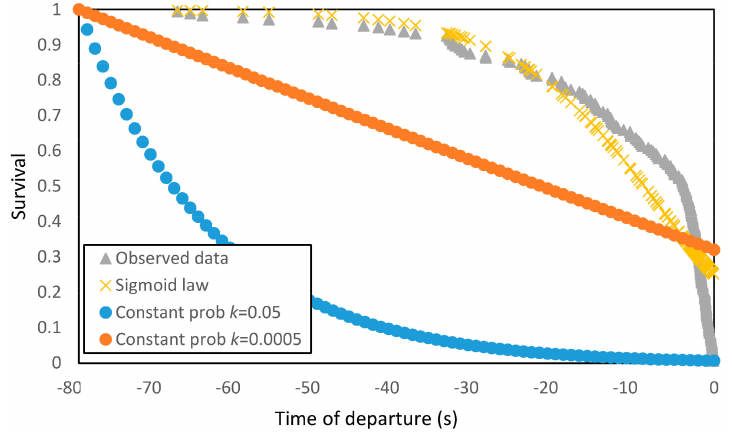
Figure 1. Survival analysis of departure time at the red light for the observed data (grey). Yellow points indicate theoretical survival following a sigmoid law (non constant probability of departures). Orange and blue points indicate theoretical survival following constant probability of departure (blue: k = 0.05, high probability to cross at the red light; orange: k = 0.0005, low probability to cross at the red